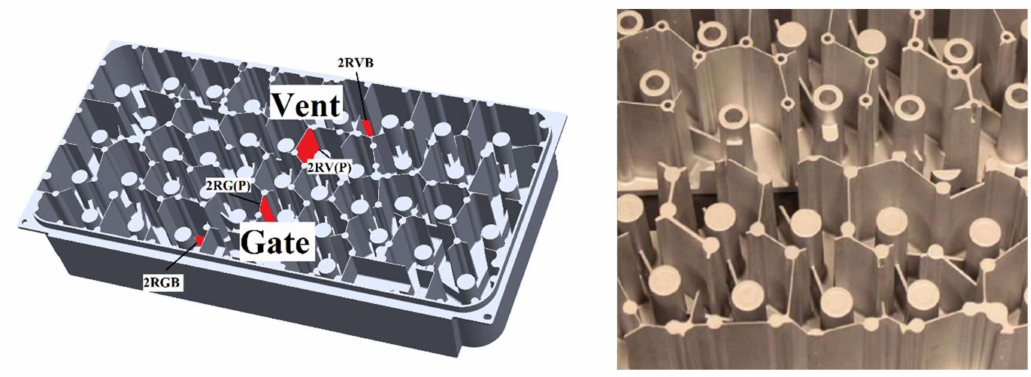
Figure 1. The experimental cavity filter used for Rheo-high pressure die cast (HPDC) process.